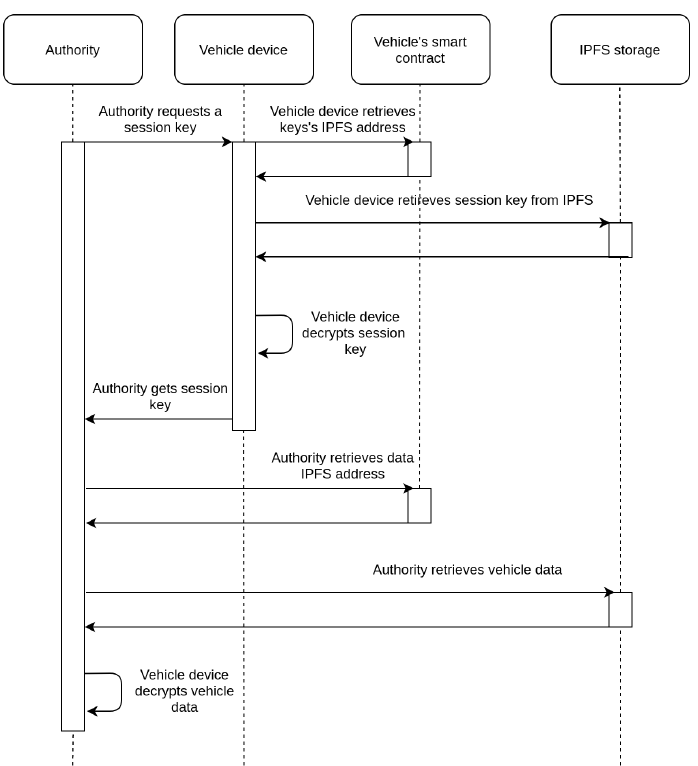
Figure 4. Sequence diagram for retrieval of data given the consent of the vehicle owner.